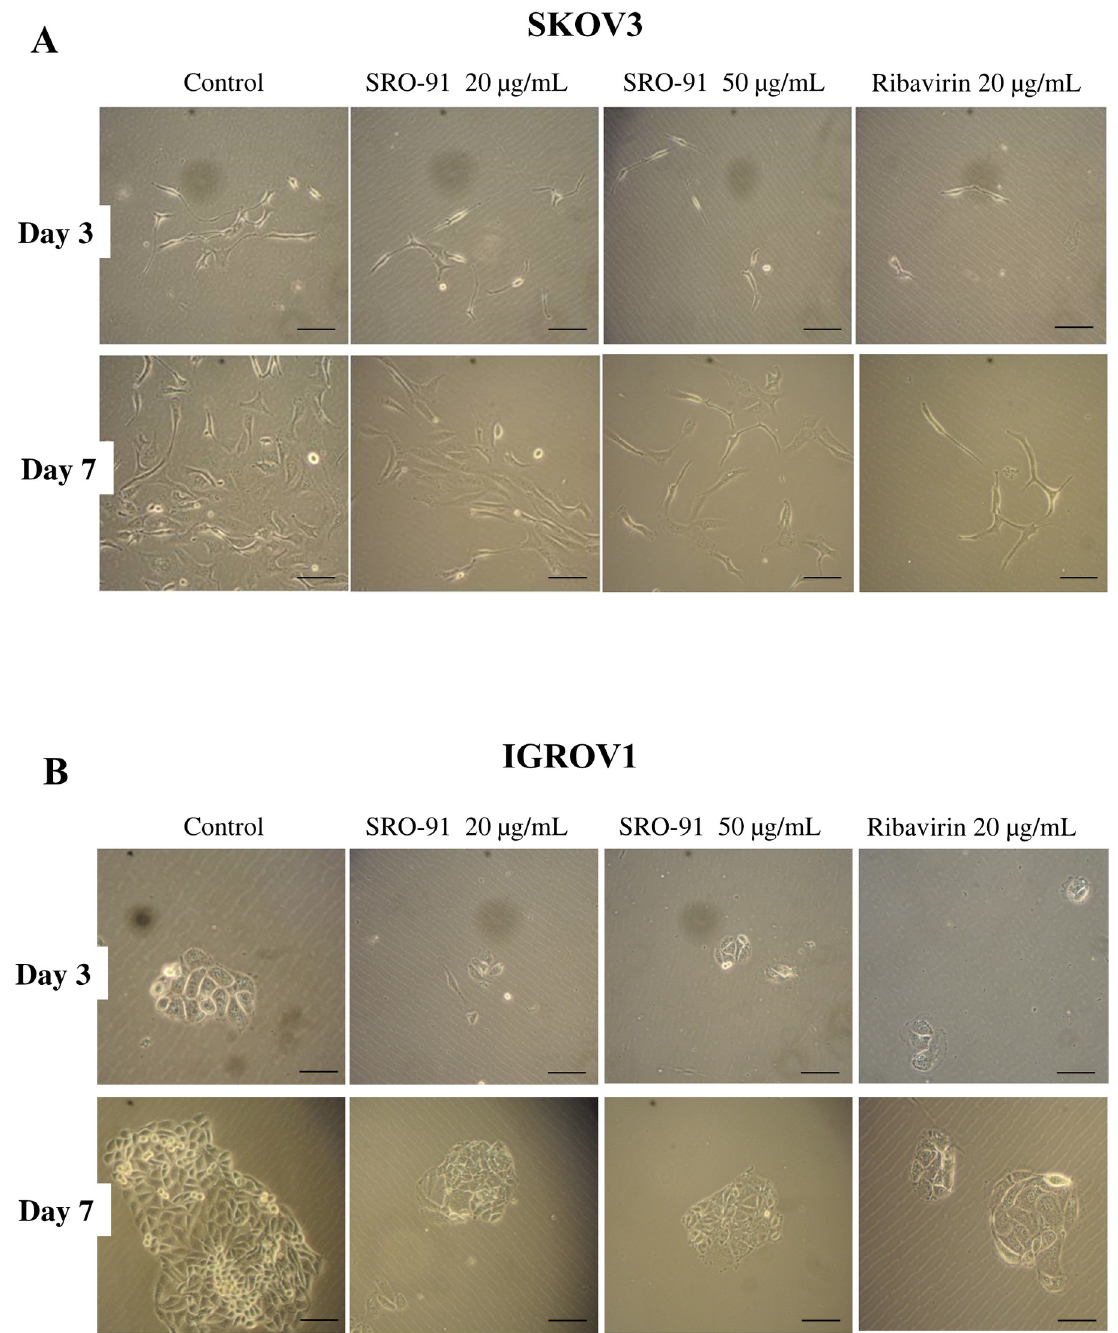
Fig 7. Cancer cells colony forming ability after SRO-91 or ribavirin treatment or without treatment (control). (A) SKOV3 and (B) IGROV1 cancer cells colony formation were followed each day during 7 days by observation of the cells by phase-contrast light microscopy. Pictures (A, B) are representative of at least five